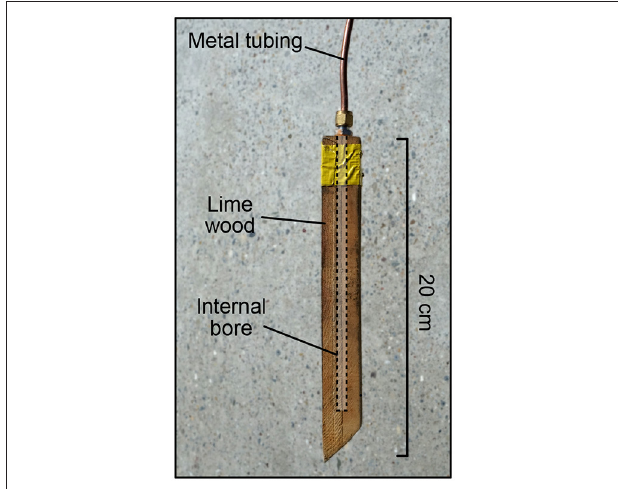
FIGURE 2 | Photo of the gas bubble diffuser for tracer gas injection at the